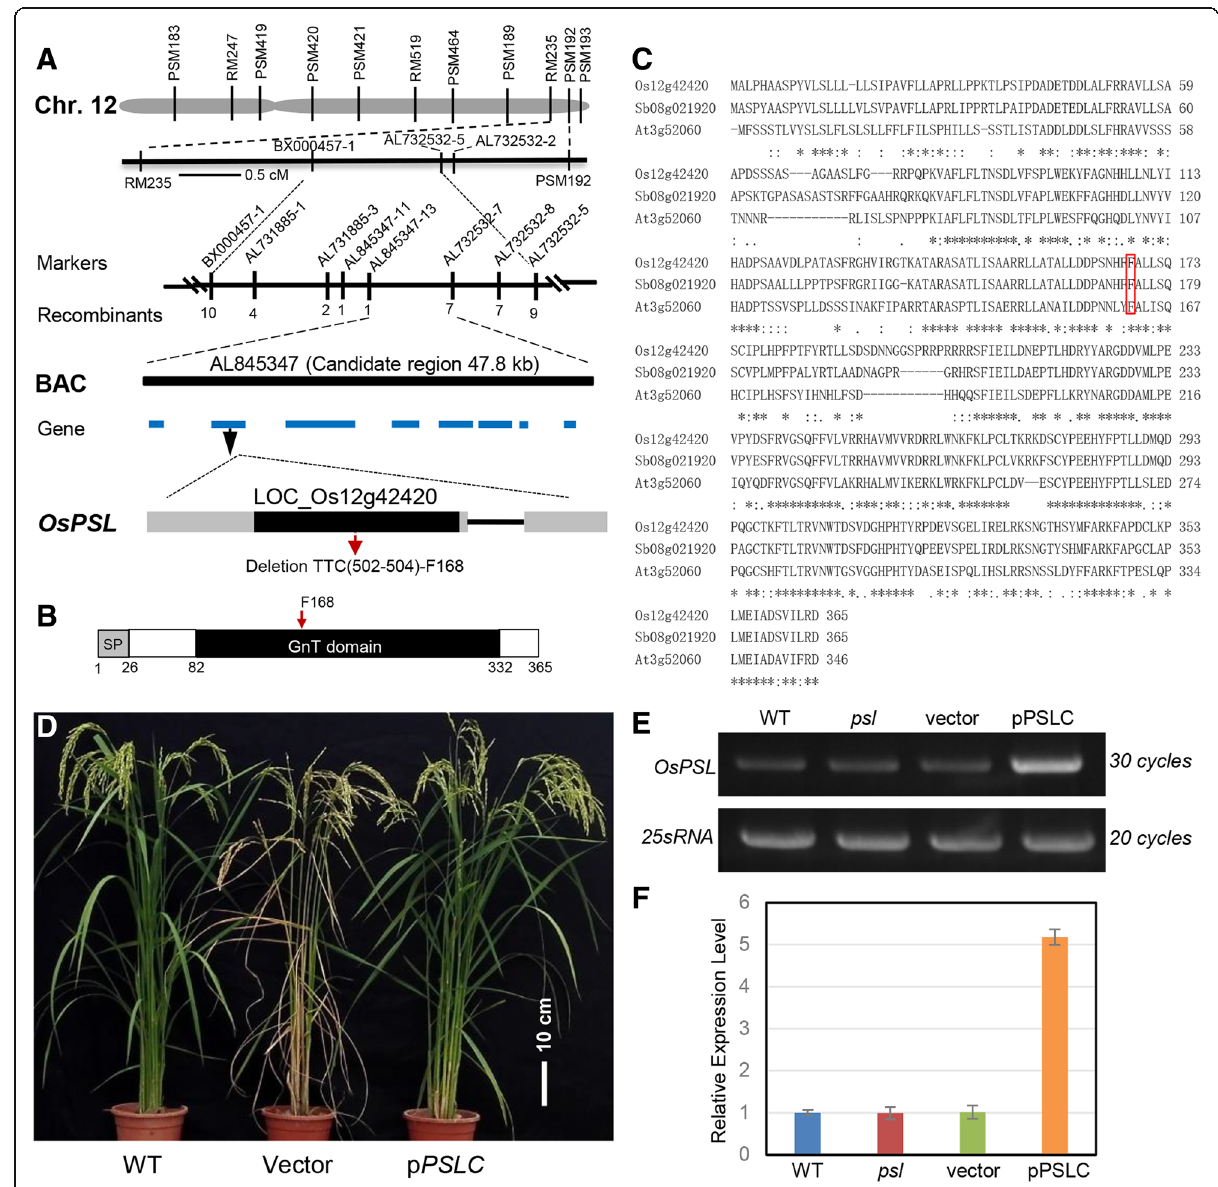
Fig. 4 Map-based cloning of the OsPSL locus. a The PSL locus was mapped to the long arm of rice chromosome 12. Black boxes indicate the coding sequence, grey boxes indicate the 5 ′ and 3 ′ untranslated regions, and lines between boxes indicate introns. Deletion site identified in the psl are indicated by a red arrowhead. b Schematic representation of the OsPSL protein domains. Positions of amino acid residues delimiting each of the indicated domains are shown. c Amino acid sequence alignment of the rice OsPSL (Os12g42420) with its homologs from Arabidopsis . thaliana (At3g52060)